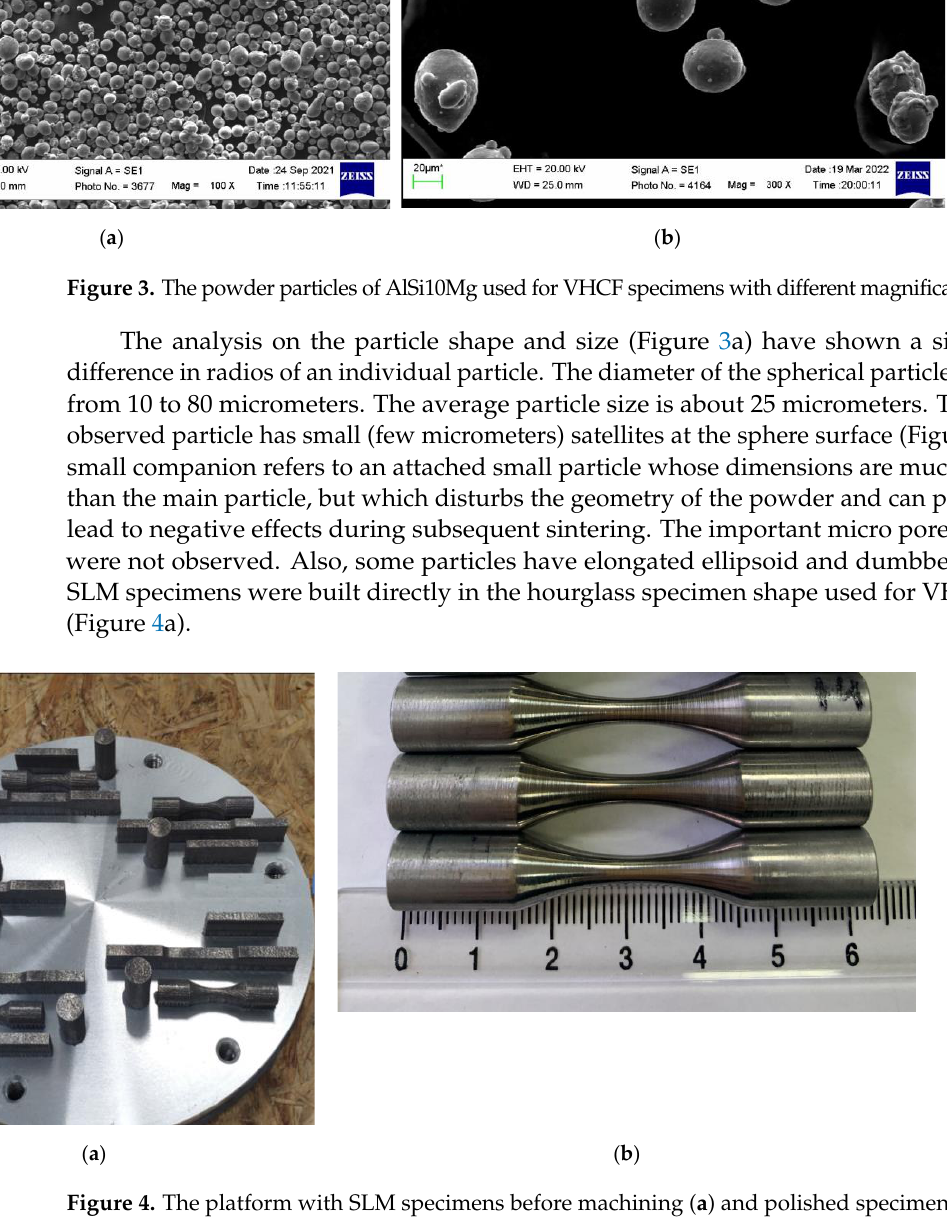
Figure 4. The platform with SLM specimens before machining ( a ) and polished specimens ( b ). The specimens were built up in the argon environment with low concentration of laboratory air (w < 0.03 %). The samples were fabricated using AlSi10Mg (RUSAL, Russia) powder via AddSol D250 (Addsol, Russia) laser melting system equipped with 400 W optical system. In-plane diameter of the circular built platform was 250 mm. Samples were built by using constant process parameters: laser power 300 W, layer thickness 30 µm, scanning speed 1600 mm/s and spot size 65 µm. The parameters were adjusted based on author’s experience [17 – 21]. After manufacturing, the samples together with the platform were placed in the furnace to remove possible temperature residual stresses. After the annealing process, the samples were cut from the platform and milled with subsequent grinding to obtain surface roughness Ra = 0.4 (Figure 5). ( a ) ( b ) Figure 5. The quality of SLM specimen surface after polishing ( a ) scan view and ( b ) profile meas- urements. The roughness investigations on the produced specimens in different directions (along the specimen axis and across) have shown the following range of Ra = 0.25 – 0.43.